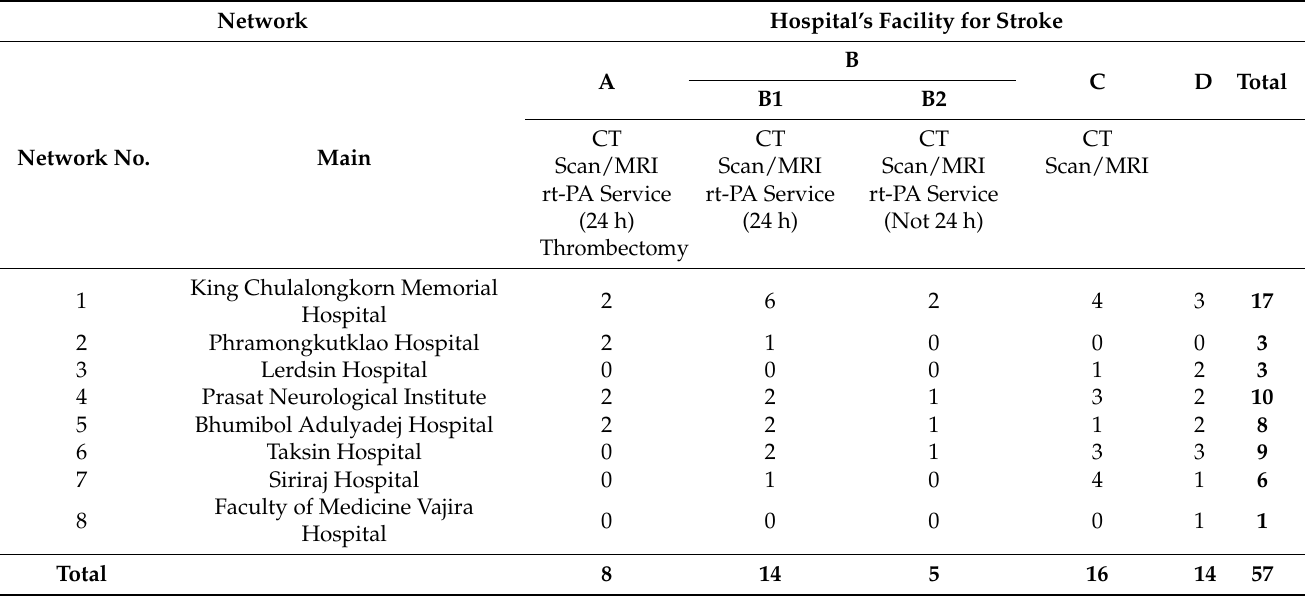
Table 2. Hospitals with stroke networks in NHSO Region 13 disaggregated by services provided. Network Hospital’s Facility for Stroke